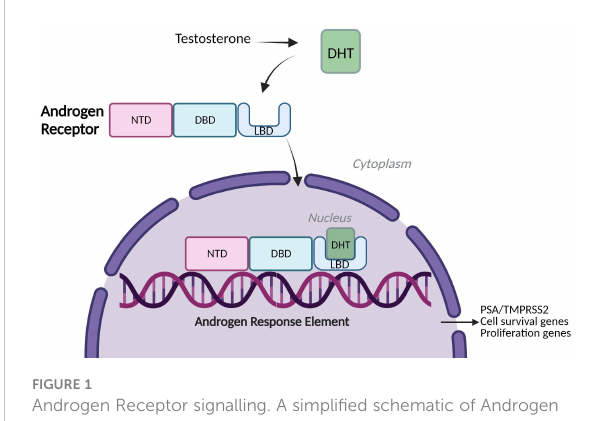
FIGURE 1 Androgen Receptor signalling. A simpli fi ed schematic of Androgen Receptor (AR) Signalling: Full-Length Androgen Receptor, a transcription factor binds the testosterone derivative, Dihydrotestosterone (DHT) in the cytoplasm. The AR translocates to the nucleus, binds to Androgen Response Elements (AREs) on DNA and drives expression of cell survival and proliferation genes and target genes such as PSA (KLK3) and TMPRSS2 (2). NTD= amino- terminal domain, DBD= DNA-binding domain, LBD= Ligand-binding